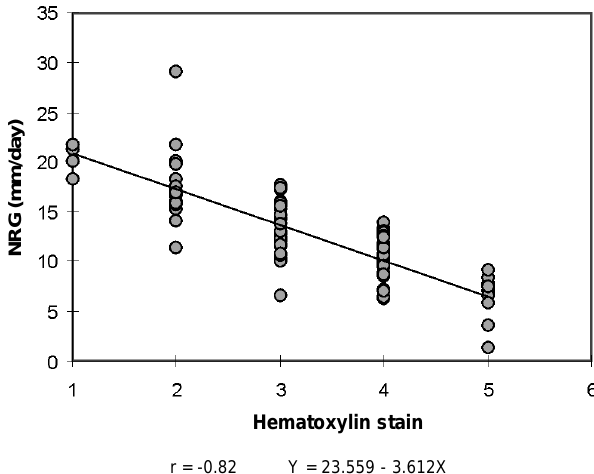
r = -0.82 Y = 23.559 - Figure 3 - Regression analysis of the data for all plants. NRG, Net root growth.